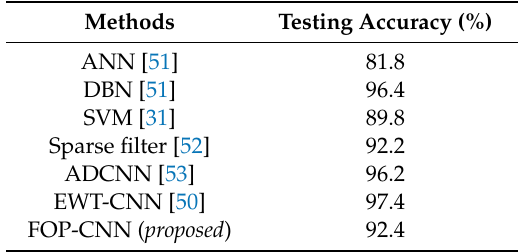
Table 5. Comparison with other algorithms based on [50].